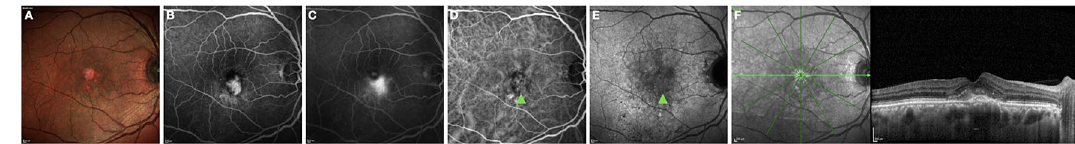
Figure 2. Multimodal imaging of a type 1 macular neovascularization associated with pachychoroid disease. ( A ) Retinal pigment epithelium alterations within the macula were detected using multicolor imaging modality. ( B , C ) Early- and late-phase fluorescein angiography (FA) demonstrates a macular hyperfluorescent area with leakage. ( D , E ) Early- and late-phase indocyanine green angiography (ICGA) displays the presence of an hyperfluorescent lesion (highlighted with green head arrows) with dye washout in the late phase. ( F ) A fibrovascular pigment epithelium detachment with subretinal hyperreflective material is detected with structural OCT.